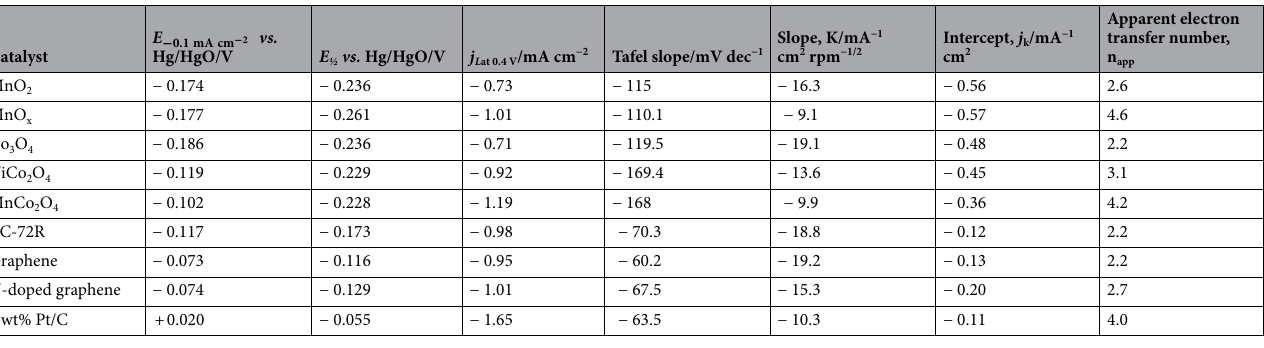
Table 2. ORR kinetic parameters from LSV, Tafel and K-L plots of